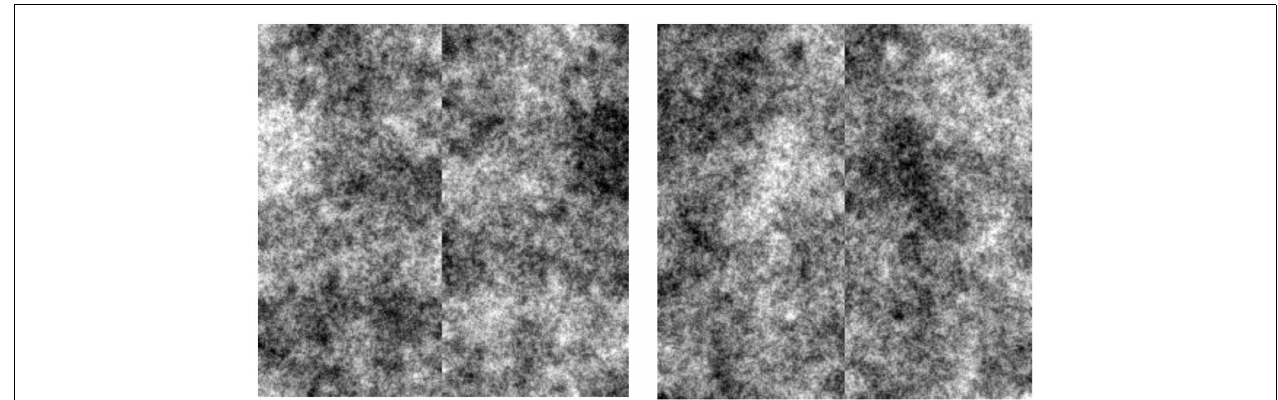
FIGURE 6 | Examples of spatially symmetric images with asymmetric contrast.